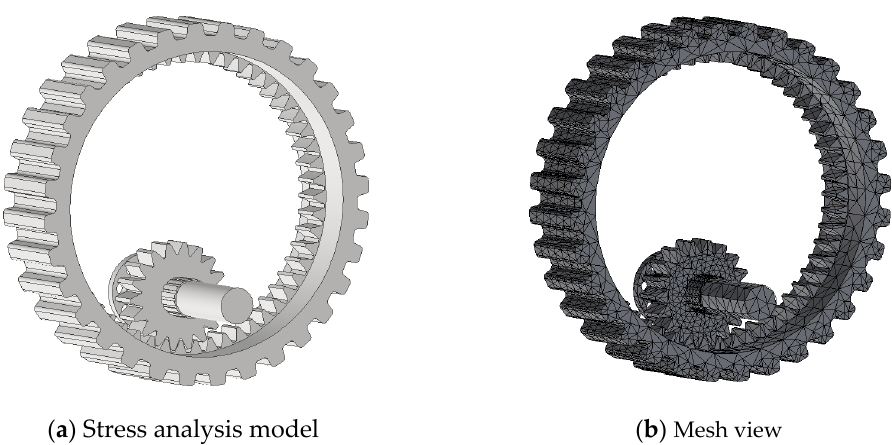
Figure 7. Stress analysis model and mesh view. ( a ) Stress analysis model. ( b ) Mesh view.